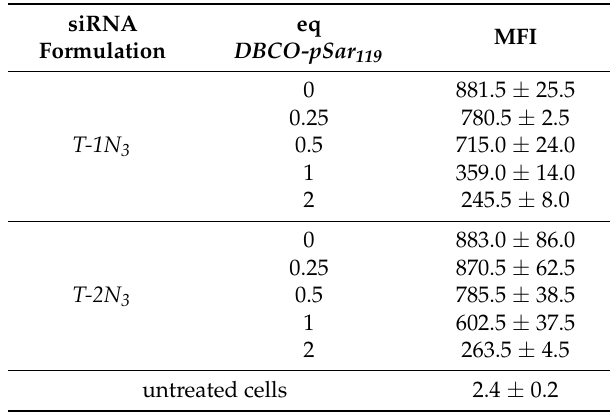
Table 2. Mean fluorescence intensity (MFI) of Cy5-labeled siRNA formulations (top: T-1N 3 ; bottom: T-2N 3 ) shielded with increasing equivalents (eq mol/mol) of DBCO-pSar 119 for cellular internalization determined by flow